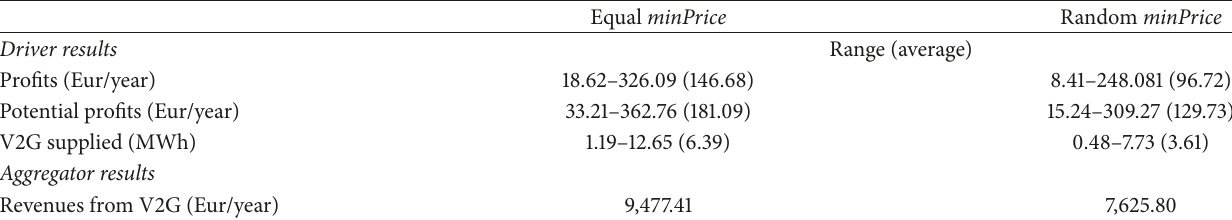
Table 5: Simulation results: drivers and aggregator